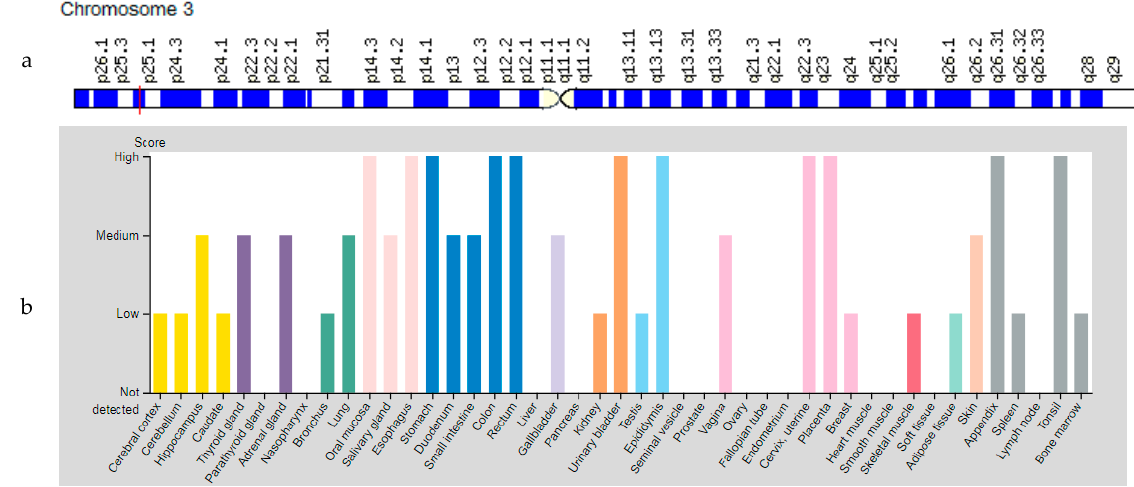
Figure 3. Location of the PPARG gene ( a ) and tissue expression of the peroxisome proliferator activated receptor gamma ( b ). The most studied SNV of the PPARG gene is C34G (rs18012825), which is a